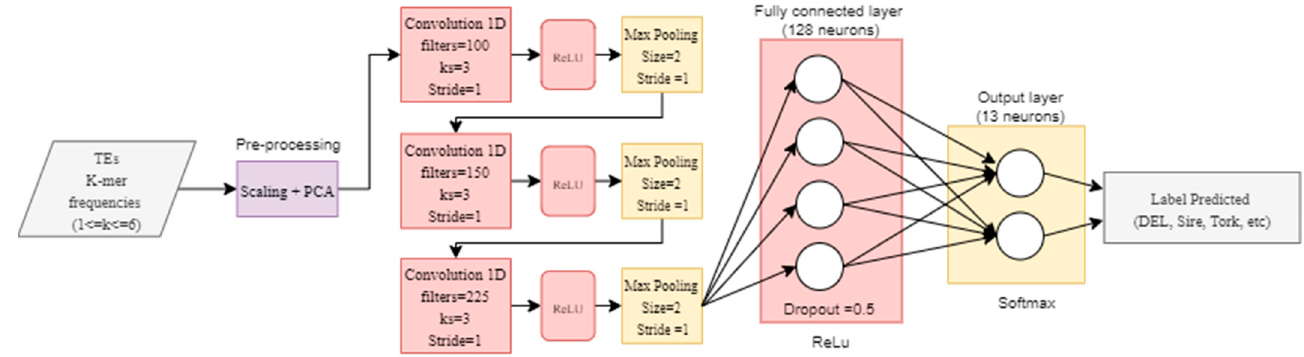
Figure 3. Implementation of the convolutional neural network (CNN) architecture proposed in DeepTE [48].